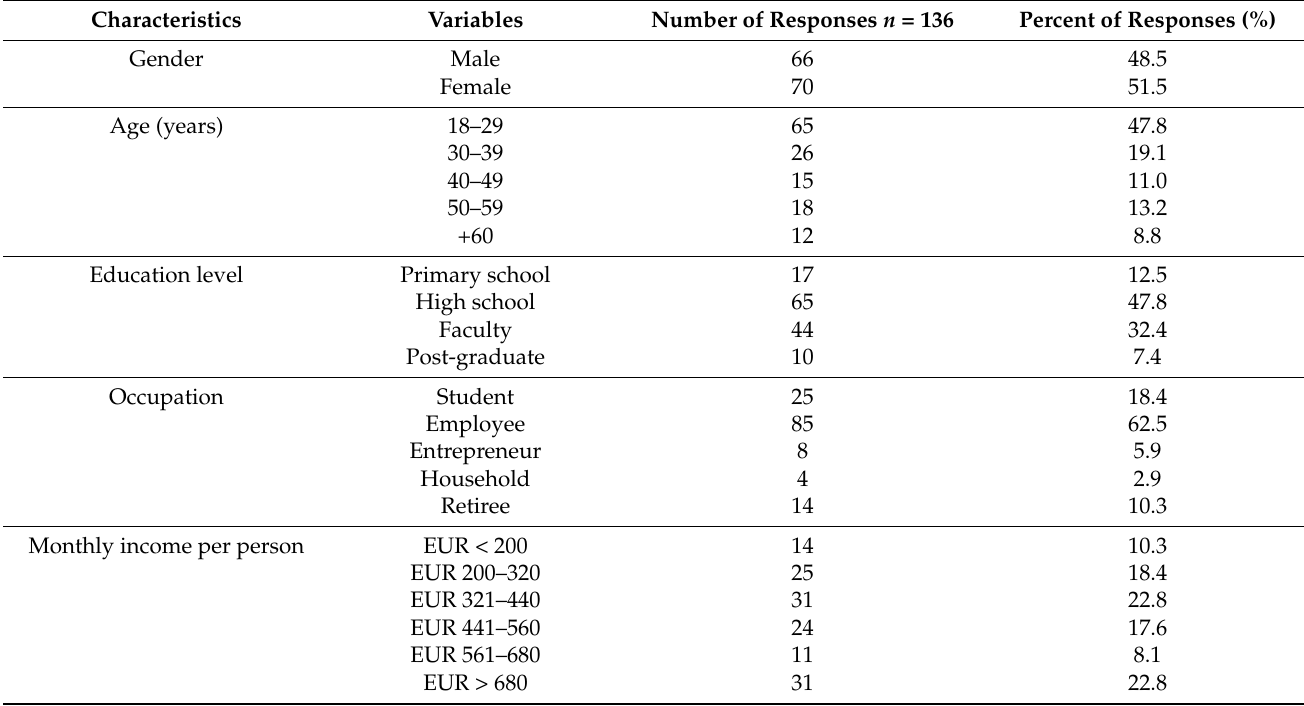
Table 1. Socio-demographic profile of